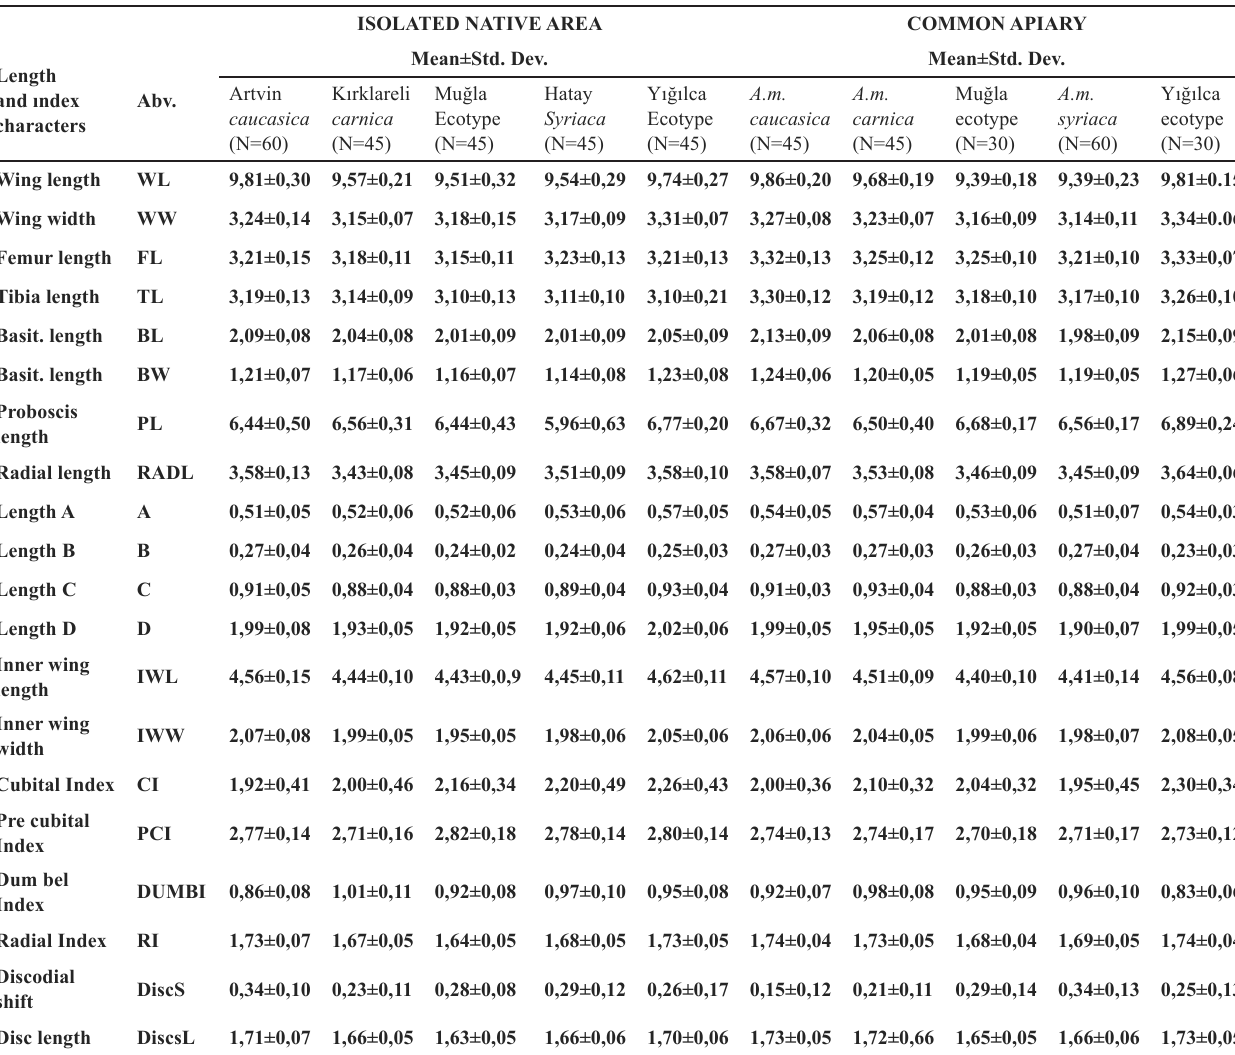
Table 4 . Means ± Stdoflengths and indexcharacters determined by standard morphometric method by using 19 landmark.